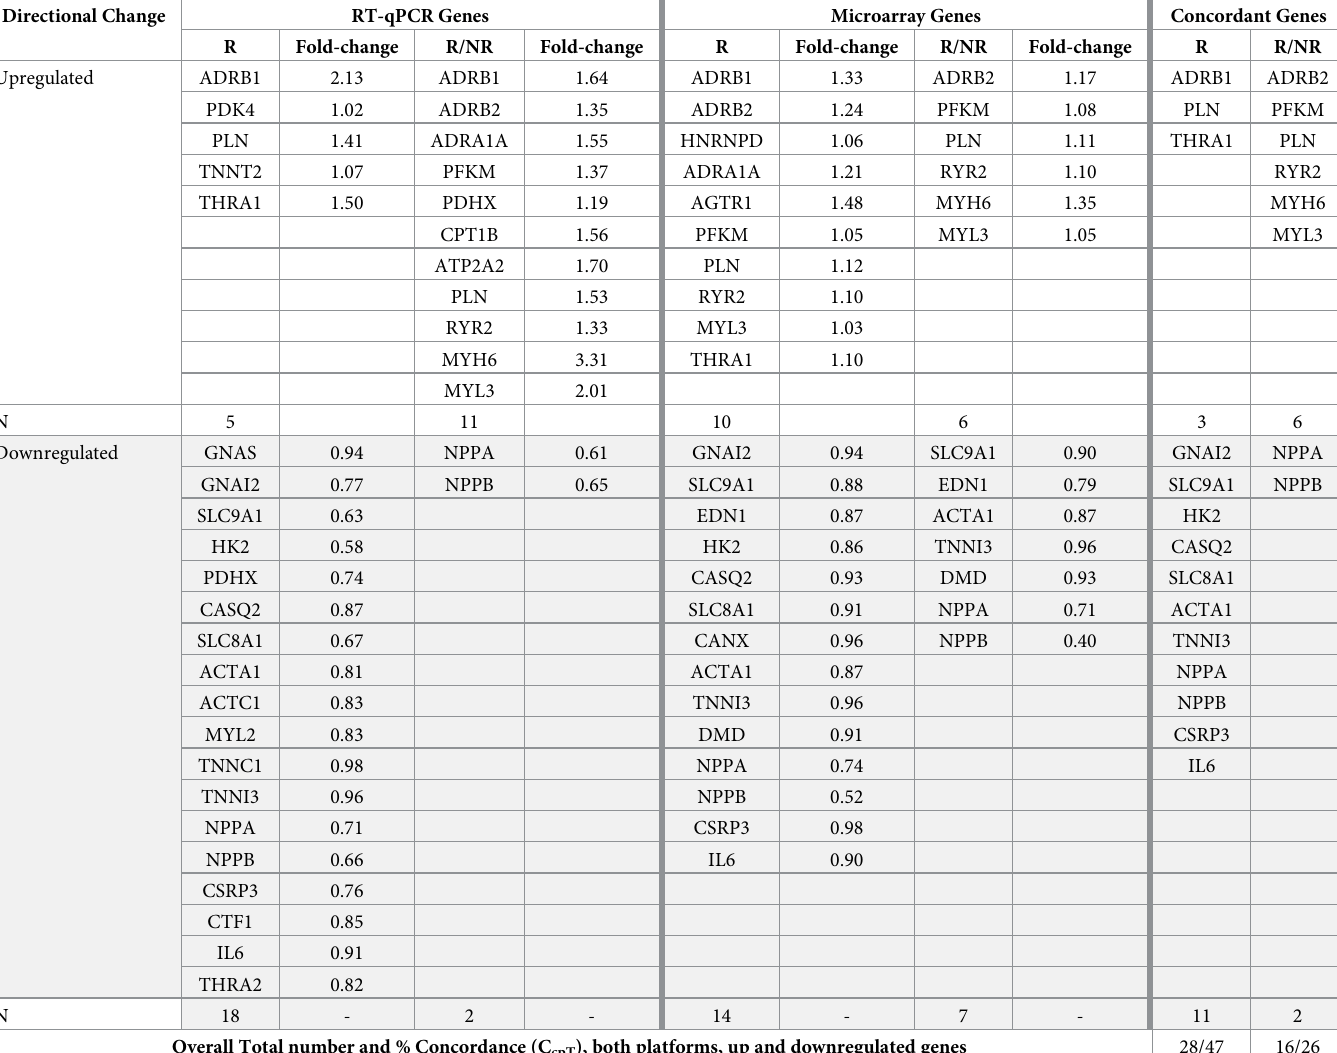
Table 1. Comparison of significantly different (P < 0.05) candidate genes (of 50 total mRNAs measured) detected by RT-qPCR or microarray in the A-S cohort. Directional Change Upregulated